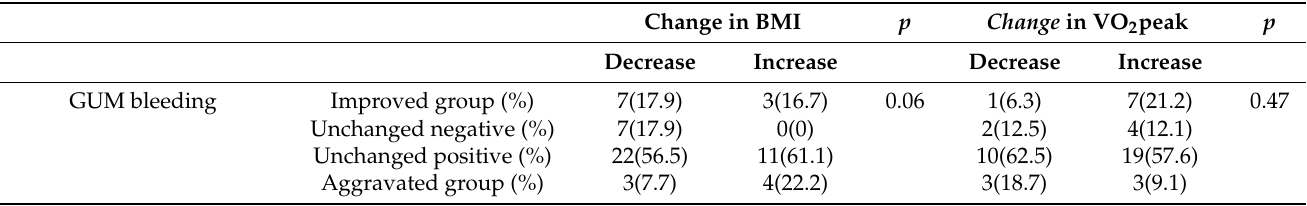
Figure 4. Degree of improvement in salivary blood state. Numbers in the figures show participants. Table 2. Relationship between the effect of exercise and the improvement of gingival bleeding or the rate of change in oral function in the intervention